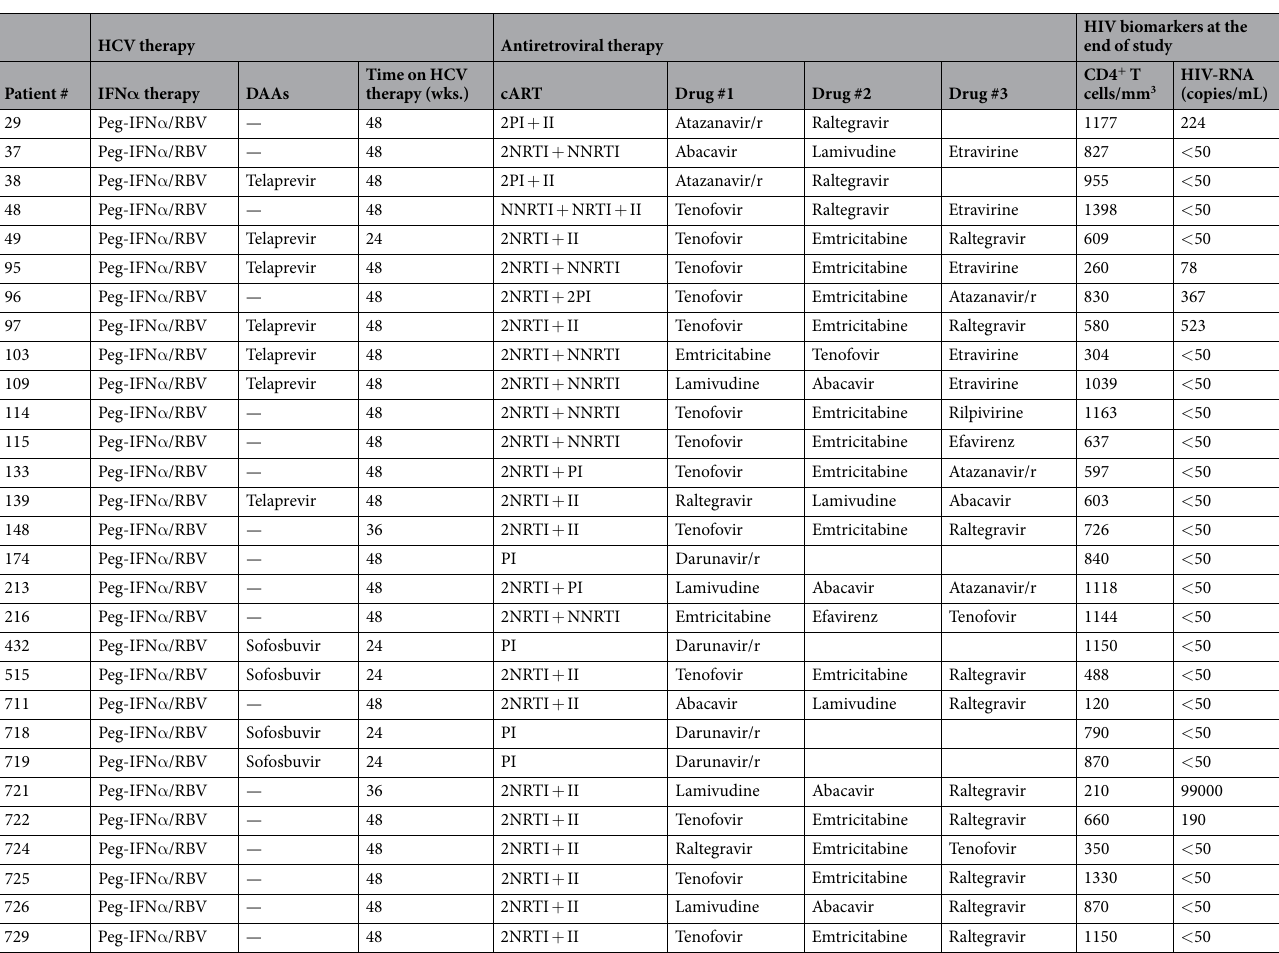
Table 2. Characteristics of the antiviral therapy in HIV/HCV-coinfected patients included in the study during the follow-up. Abbreviations: HCV, hepatitis C virus; HIV, human immunodeficiency virus; HIV-RNA, HIV plasma viral load; peg-IFN α , PEGylated interferon-alpha; RBV, ribavirin; DAAs, direct-acting antivirals; cART, combined antiretroviral therapy; NRTI, nucleoside analogue HIV reverse; NNRTI, non-nucleoside analogue HIV reverse transcriptase inhibitor; PI, protease inhibitor; II, integrase